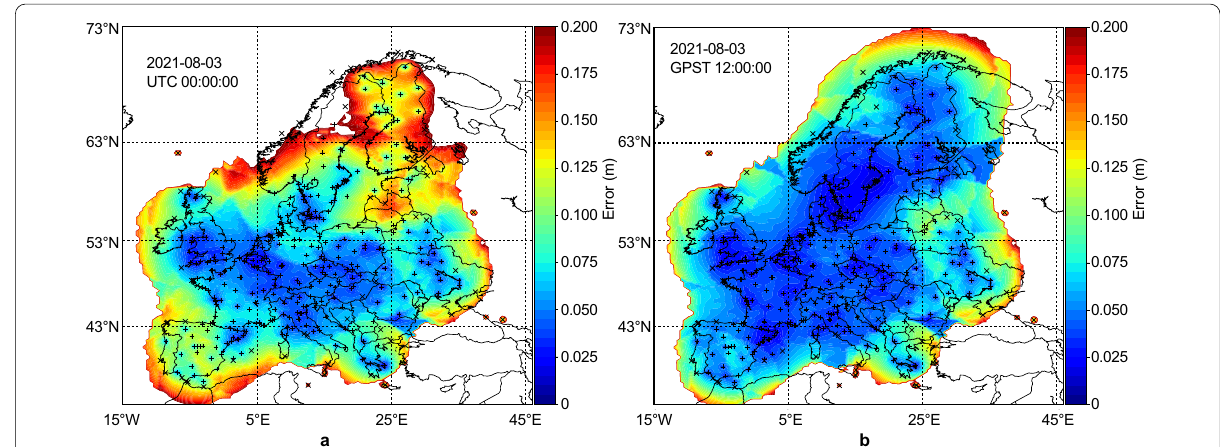
Fig. 4 The slant ionosphere interpolation error map (in meter) at two epochs, 0 o’clock ( a ) and 12 o’clock ( b ), 03 August, 2021 (DOY 215)